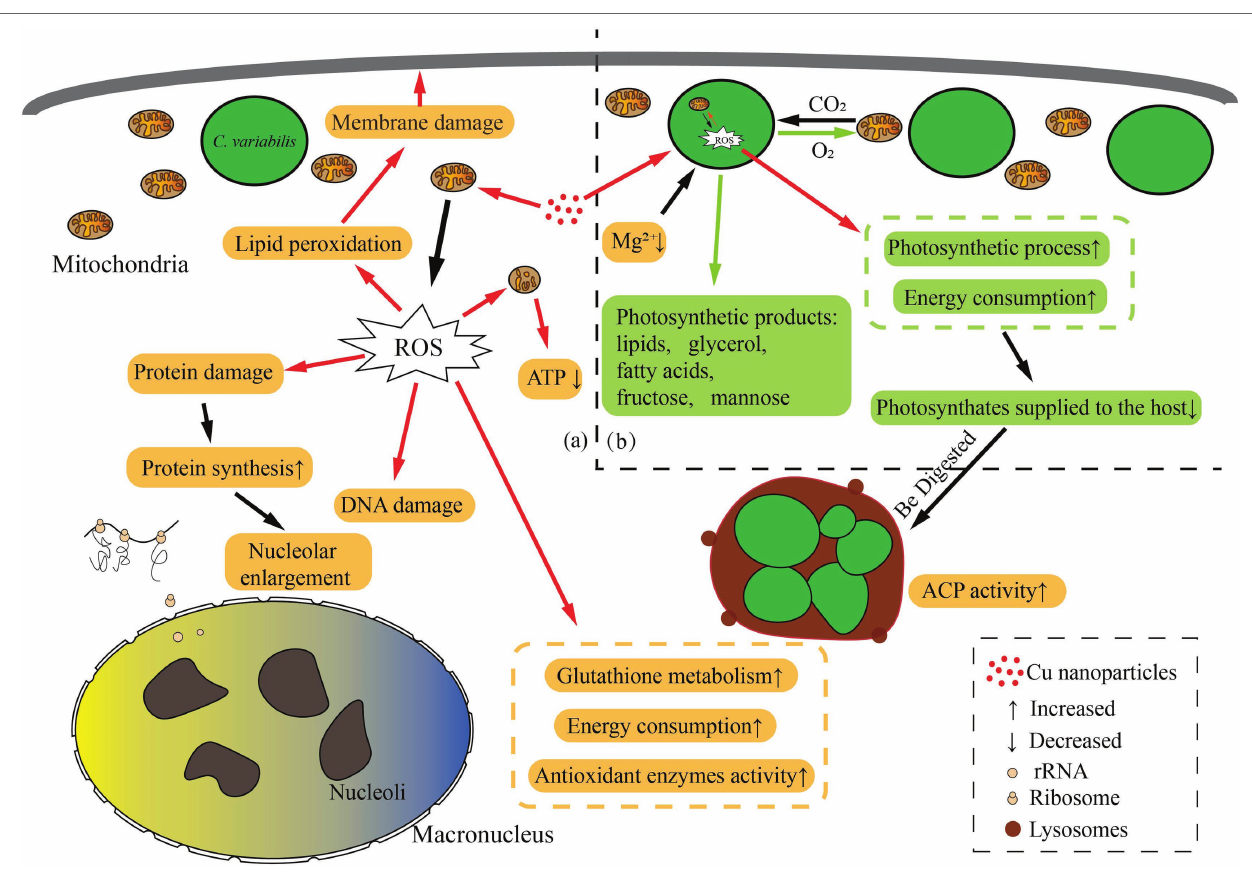
FIGURE 8 | Schematic representation of biological pathways in the Paramecium bursaria – Chlorella symbiotic system affected by CuNPs. (a) The changed biological pathways in P. bursaria ; (b) the changed biological pathways in symbiosis algae. The orange box represents the affected pathway within the P. bursaria ; the green box represents the affected pathway within the Chlorella ; and the red arrow indicates the damage